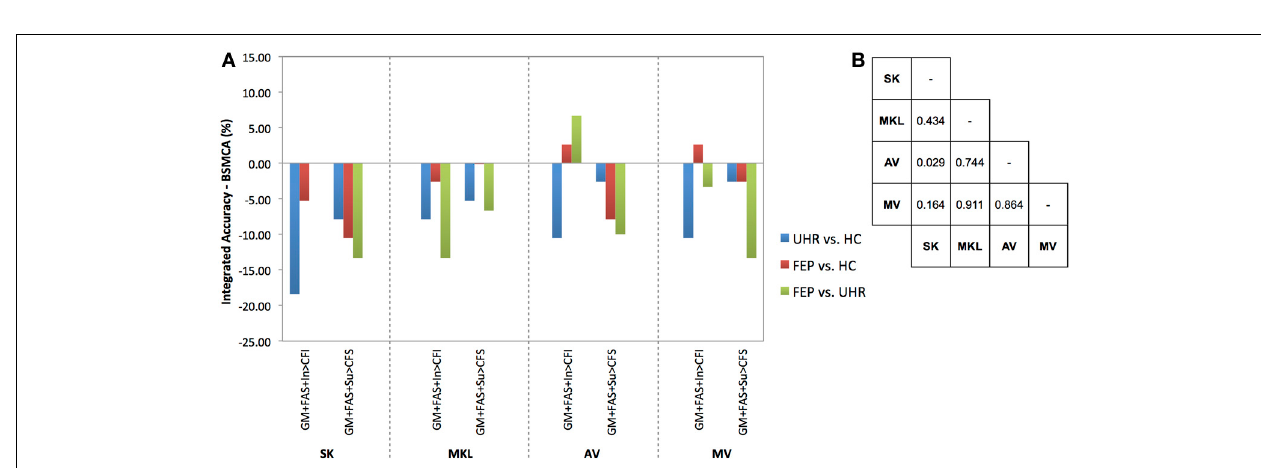
FIGURE 4 | (A) Difference between the integrated accuracy achieved using SK, MKL, AV, or MV, and the BSMCA, discriminating UHR and FEP subjects from HCs, and each other, using three-way combinations of sMRI, DTI, and fMRI data. (B) Results of McNemar’s tests comparing subject classifications achieved by each integrative method collapsed across SVM contrasts and data combinations. SK, Un-weighted simple sum of kernels; MKL, Multi-Kernel Learning; AV,